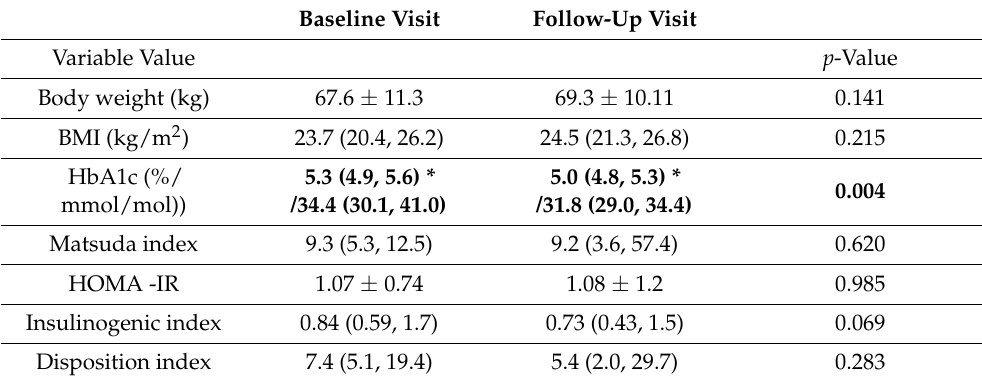
Table 1. Anthropometric and biochemical characteristics of subjects with RPH ( n = 29) at baseline and at the follow-up visit after on average 6.4 ± 4.2